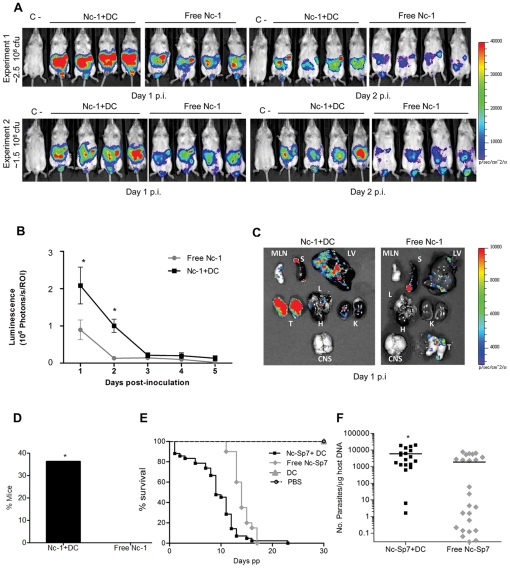
Adoptive transfer of N. caninum tachyzoite-infected DC in mice and parasite transmission to offspring during pregnancy.
A. Kinetics of dissemination of N. caninum in BALB/c mice inoculated i.p. with ∼2.5×106 cfu (experiment 1) or ∼1.5×106 cfu (experiment 2) free Nc-1Luc tachyzoites or Nc-1Luc-infected DC. Progression of N. caninum infection and parasite biomass was assessed by bioluminescence imaging (BLI) using the IVIS Spectrum imaging system. Photon emission (photons s−1 cm−2) was assessed for 180 s 10–12 min after i.p. injection of d-luciferin. Images are from two experiments with four mice per group on days 1 and 2 p.i. Colour scales indicate photon emission (photons s−1 cm−2) during 180 s exposure time. B. Total photon emission analysis of BALB/c mice inoculated i.p. with free Nc-1luc tachyzoites or Nc-1Luc-infected DC on days 1–5 after inoculation. There was a dramatic increase in the parasite burden in mice inoculated with Nc-1Luc-infected DC compared to free Nc-1Luc on days 1 and 2 p.i. (P<0.05; Student's t test). Compiled data are from two independent experiments (day 1 p.i. n = 11; day 2–5 p.i. n = 8). C. Imaging of infected organs ex vivo. Organs were dissected on day 1 p.i from mice infected with free Nc-1Luc tachyzoites or Nc-1Luc -infected DC, respectively. Parasite load was significantly higher in the Nc1Luc-infected DC group. Signals were observed in images of the testis (T), liver (LV), spleen (S), mesenteric lymph nodes (MLN), lung (L), kidney (K) and brain (CNS). No signal was detected in the heart (H). D. Detection of N. caninum DNA in mouse brains on day 1 p.i. by real-time PCR as indicated under Materials and Methods. Y-axis indicates percentage of mice with positive PCR for mice infected with Nc-1Luc-infected DC or free Nc-1Luc tachyzoites, respectively (n = 11; positive 4/11 versus 0/11; P<0.05, Fisher F test). E. Kaplan–Meier survival curves for neonates born to dams inoculated with ∼2.5×106 cfu of free Nc-Spain 7 tachyzoites or Nc-Spain 7-infected DC, 5×106 non-infected DC or PBS buffer. The curves represent the percentage of animals surviving over a period of 30 days post-partum (pp). Vertical steps downward correspond to days pp when a mouse died or was sacrificed. Symbols indicate censored observations. The number of dead mice was registered daily, and the median survival time of the Nc-Spain 7-infected DC group was significantly shorter than that of the free Nc-Spain 7-infected group (P<0.001, Log-rank test). Compiled data are from two independent experiments (n = 7–14 pregnant mice per group). F. Parasite loads in brain from offspring quantified by real-time PCR and expressed in terms of number of parasites per µg of host DNA. Pups born to mice inoculated with Nc-Spain 7-infected-DC displayed significant higher parasite loads than the free Nc-Spain 7-infected group (P<0.01; Student's t test). The data are represented as individual points and horizontal lines correspond to the mean value. Compiled data are from two independent experiments.